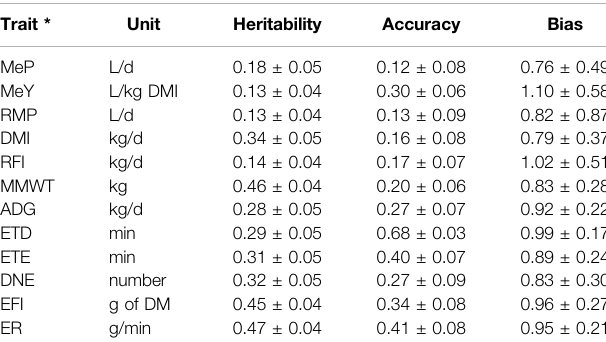
TABLE 4 | Estimated heritabilities, genomic prediction accuracies and bias for methane emissions, production, maintenance and feeding behaviour traits in post-weaning, hogget, and adult Australian Maternal Composite sheep. * Methane production (MeP), methane yield (MeY), residual methane